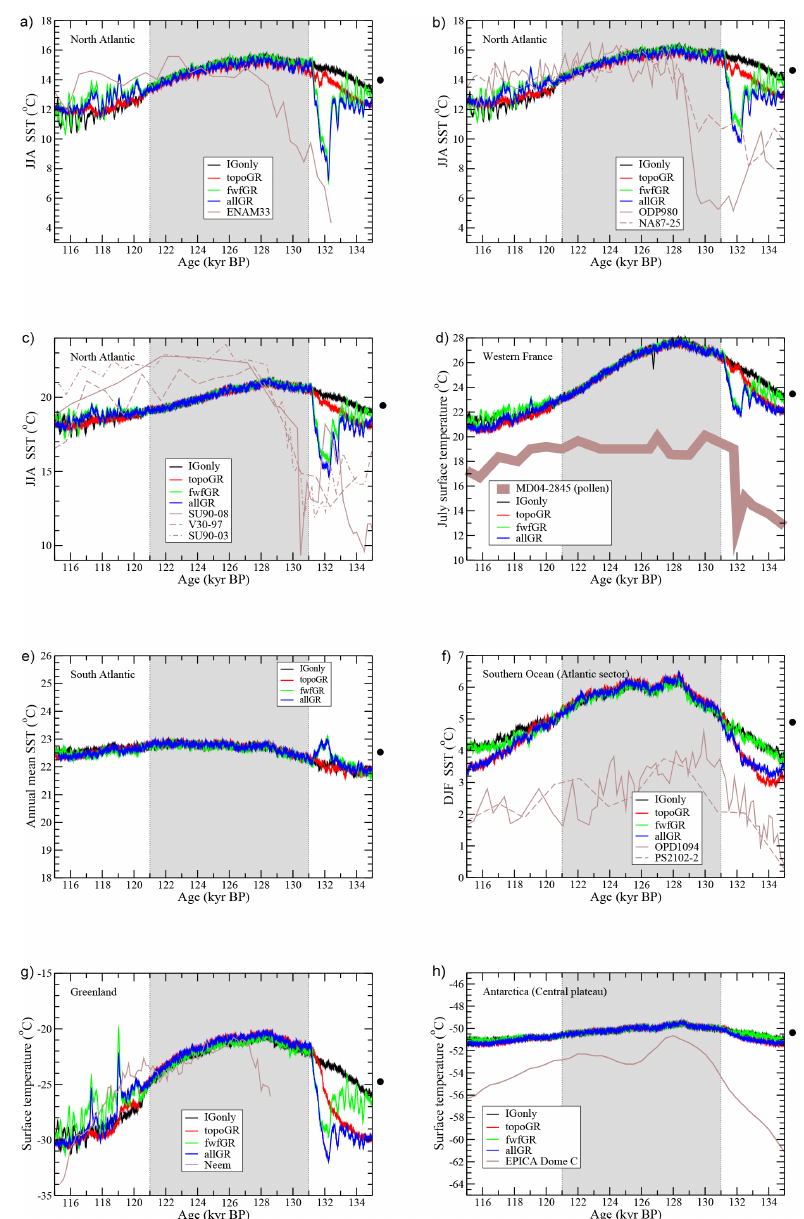
Figure 7. Comparison of reconstructed and simulated temperatures in different regions using different boundary conditions (see text and Table 1). (a) North Atlantic summer SST ( ◦ C) (ENAM33; 61.27 ◦ N, 11.16 ◦ W, Rasmussen et al., 2003b); (b) NE Atlantic summer SST ( ◦